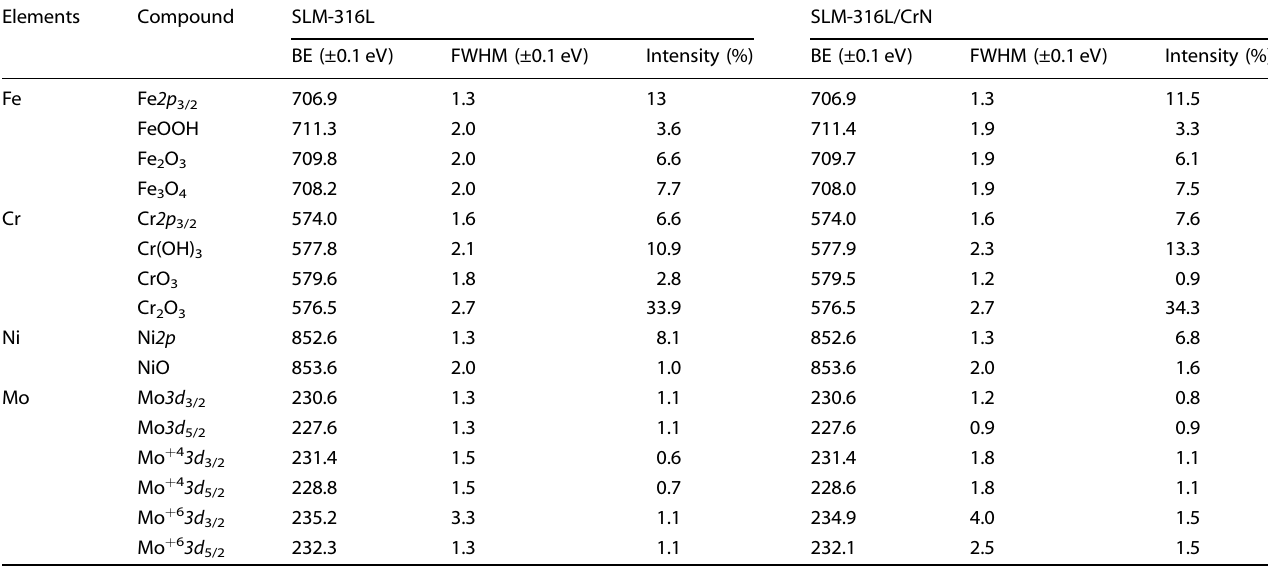
Table 1. XPS parameters of SLM-316L and SLM-316L/CrN. Elements Compound